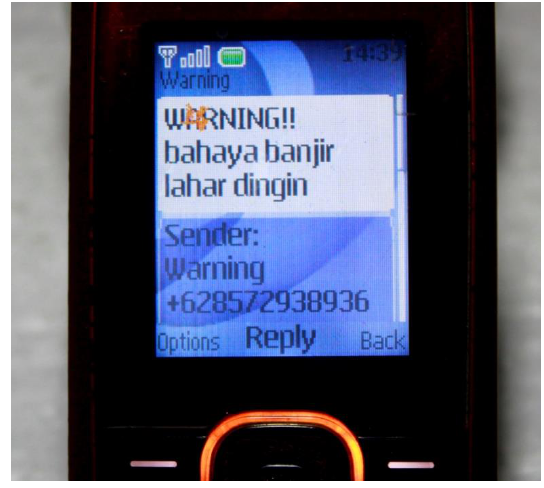
Figure 9. A warning sent via SMS to an FPRB